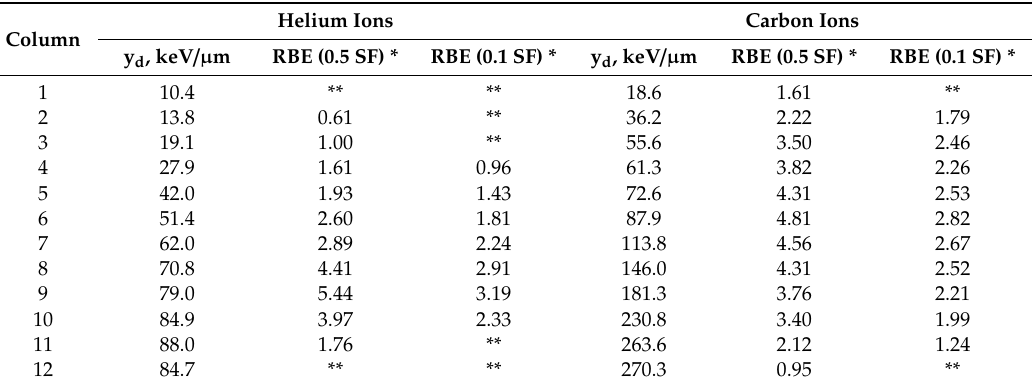
Table 2. Heavy ion RBE values for H1437